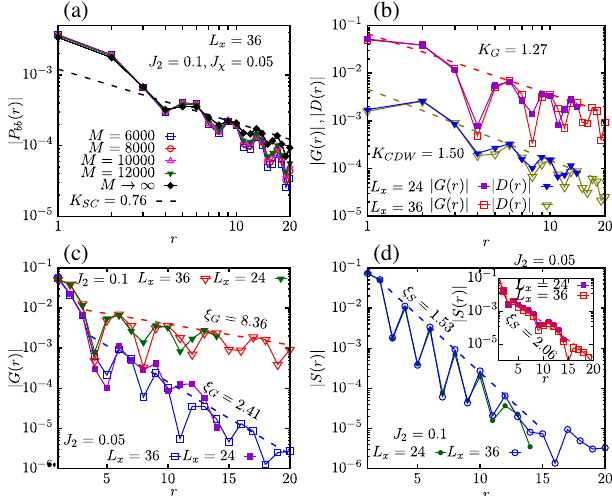
FIG. 3. Pairing and other correlations in SC2. (a) The SC pairing correlations for different bond dimensions M at J 2 ¼ 0 . 1 ; J 0 . 05 for the N ¼ 36 × 6 system. r is chosen along the x χ ¼ direction r ¼ ð r; 0 Þ , and the reference point is r 0 ¼ ð L x = 4 ; y 0 Þ to avoid the boundary effect (the results are independent of y 0 because of the translational invariant along the y direction). The straight-line fit in the log-log plot of the extrapolated data in the infinite M limit follows a power-law behavior. (b) The density- density correlation j D ð r Þj and single-particle correlation j G ð r Þj which are fit by the power-law relation for N ¼ 24 × 6 and 36 × 6 , at J 0 . 1 ; J 0 . 05 . (c) The comparison of j G ð r Þj at 2 ¼ χ ¼ J 0 . 05 and 0.1 with the same J 0 . 05 , which demonstrates 2 ¼ χ ¼ the fast growing of the correlation length ξ G with the increase of J S ð r Þj in the 2 . (d) The exponential decay of the spin correlations j main figure and its inset for the same parameters as in (c), where r > 15 data points are ignored in the fitting, because their values are comparable to the numerical truncation error. The doping level is δ ¼ 1 = 12 . The obtained fitting exponents or correlation lengths have error bars around 0.02, except for the one in the inset in (d), which is around